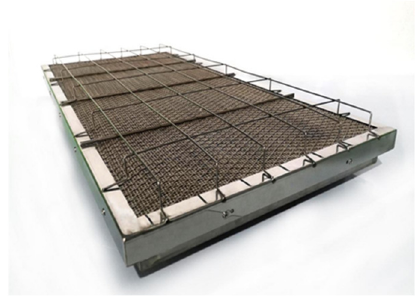
Figure 3. Catalytic infrared radiation panel. Table 1. Details of the experimental instruments.